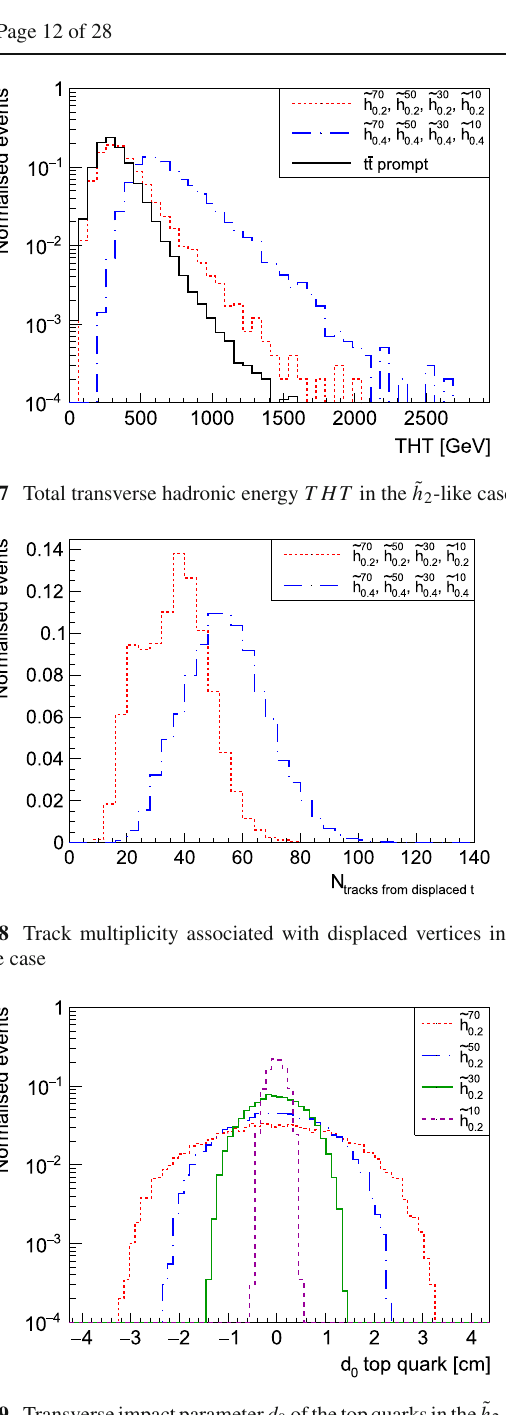
Fig. 29 Transverseimpactparameter d 0 ofthetopquarksinthe ˜ h 2 -like = 200 GeV case with m ˜ χ 0 1